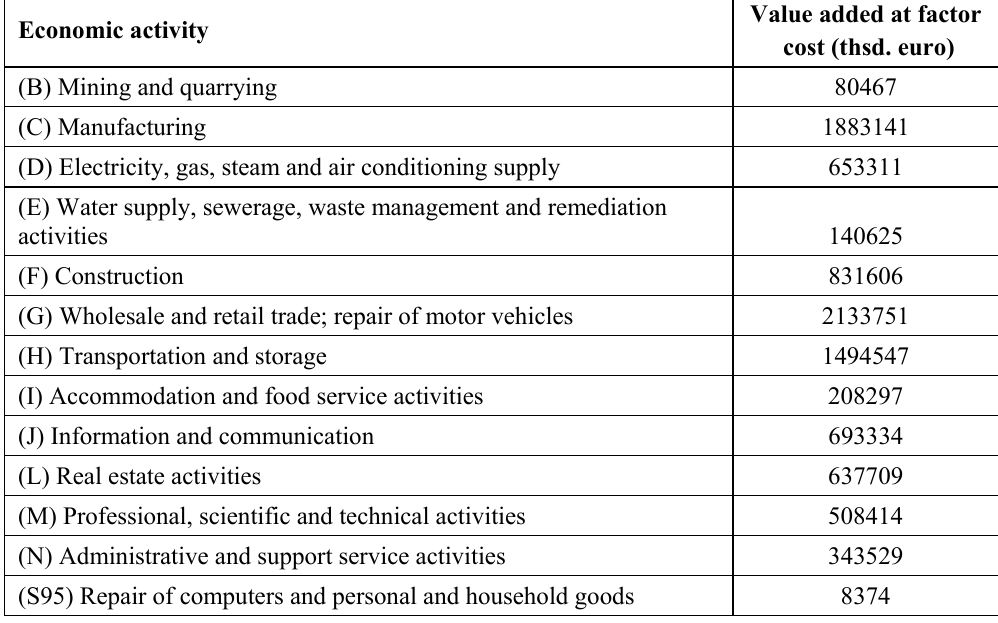
Table 1. Value Added at Factor Cost in Latvia in 2013 (thsd. euro) (NACE Rev. 2. B-N, S95; without K (Central Statistical Bureau of Latvia, 2015) Economic